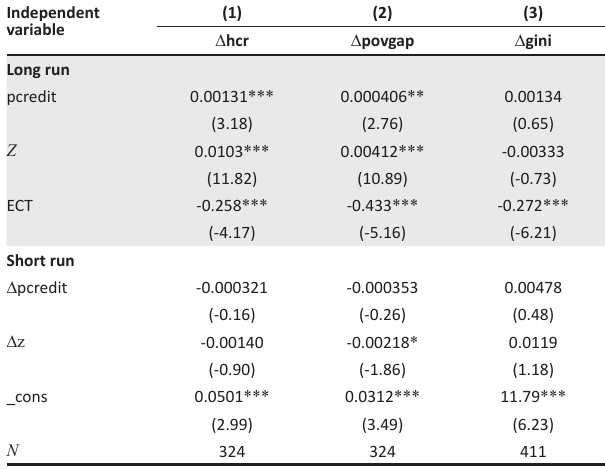
TABLE 3: Summary of the pooled mean group on the cointegration of poverty proxies and financial intermediation and financial stability. Independent